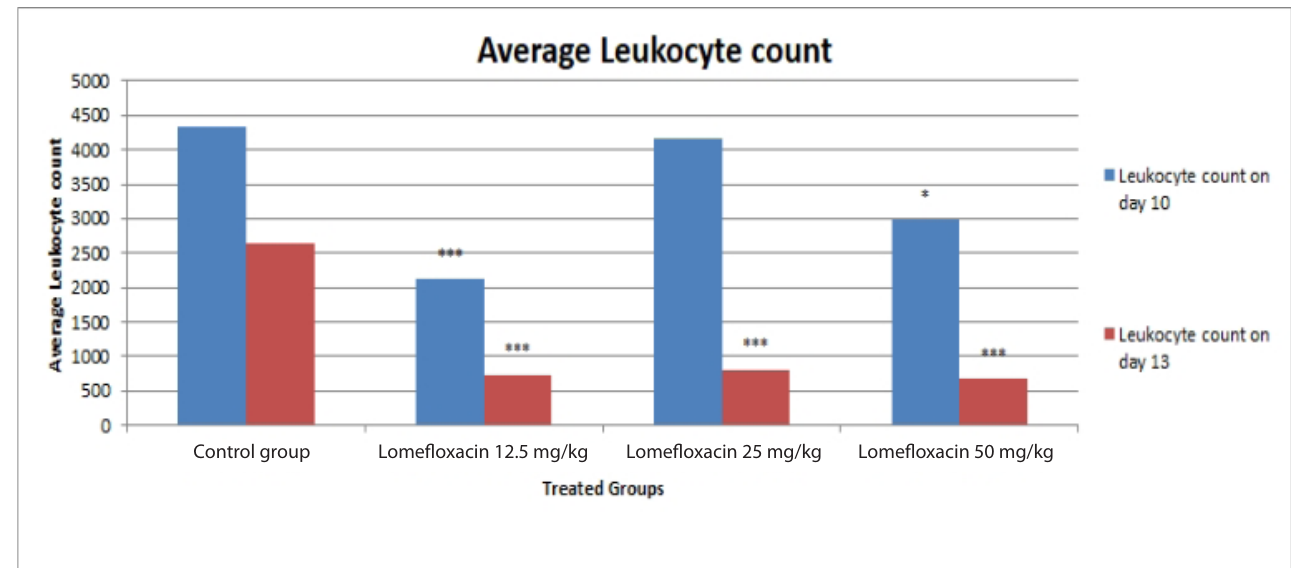
FIGURE 2 (A ) - Leukocytes count befor e and after cyclophophamide administration.